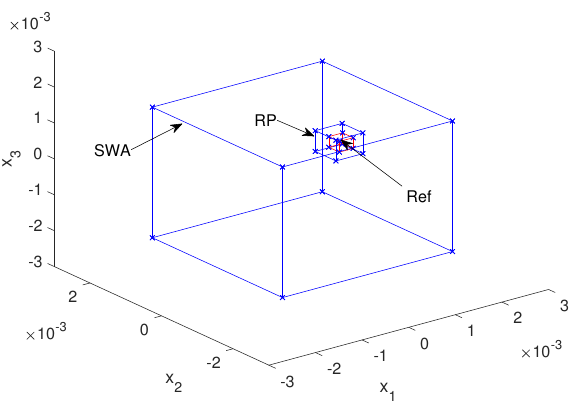
Figure 8. Ref, SWA and RP for pH